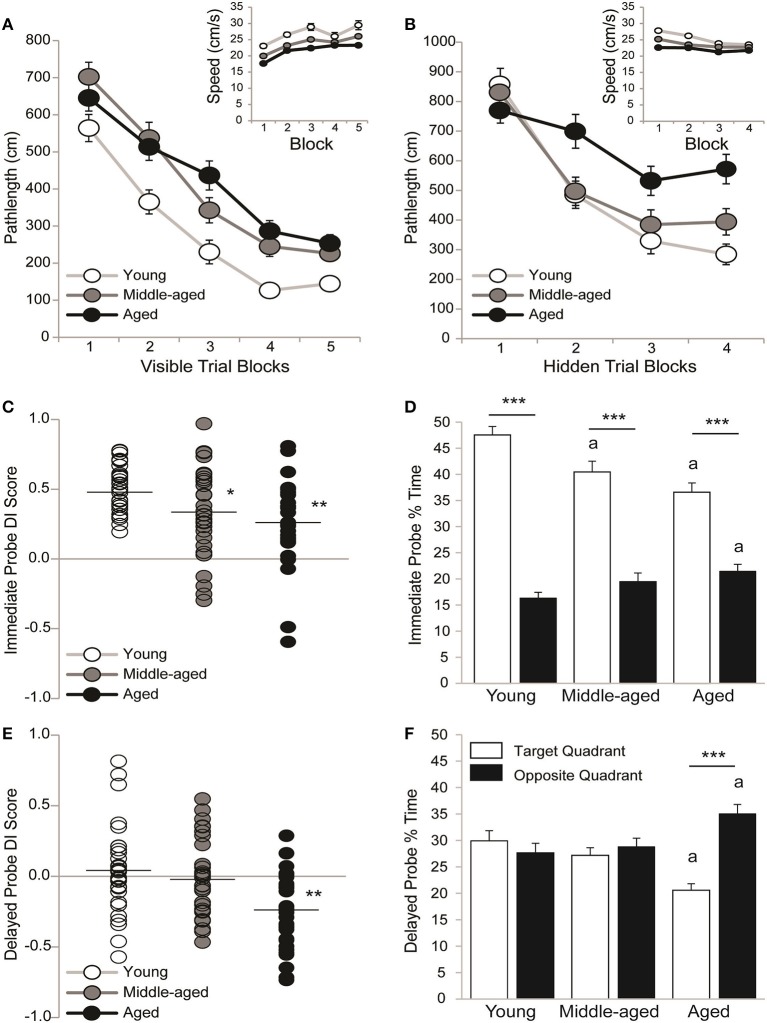
All rats learned information about but did not remember a hidden platform location. Group means (±S.E.M.) or individual DI scores with group means represented by the black line are shown for young (white circles), middle-aged (gray circles), and aged (black circles) rats and % time spent in the target (white bar) and opposite (black bar) water maze quadrant. (A) Rats swam more directly to a visible platform across training blocks (Block 1 > 2 > 3 > 4 and 5; p < 0.0001) but young rats outperformed middle-aged and aged rats (p < 0.001) on all blocks combined. Swim speeds declined with age (inset; young vs. middle-aged vs. aged; p < 0.05). (B) Aged rats swam more circuitous routes to the hidden platform that young or middle-aged rats (p < 0.01) and young rats showed more uniform improvement across training blocks (Block 1 > 2 > 3 and 4; p < 0.05) than middle-aged (Block 1 > 2–4; p < 0.001) and aged rats (Block 1,2>3,4; p < 0.05). Swim speeds declined with age (young vs. middle-aged vs. aged; p < 0.01). (C) Young rats outperformed middle-aged (*p < 0.05) and aged rats (**p < 0.01) on the immediate probe trial. (D) During the immediate probe trial, all age groups spent more time in the target vs. opposite quadrant (***p < 0.001) but middle-aged and aged rats spent less time in the target quadrant (ap < 0.05) and aged rats spent more time in the opposite quadrant (ap < 0.01) than young rats. (E) DI scores were lower in aged rats than in young or middle-aged rats (**p < 0.01). (F) Aged rats spent more time in the opposite vs. target quadrant (***p < 0.001) and less time in the target and more time in the opposite quadrant than young rats (ap < 0.05) but neither young nor middle-aged rats discriminated the target quadrant.